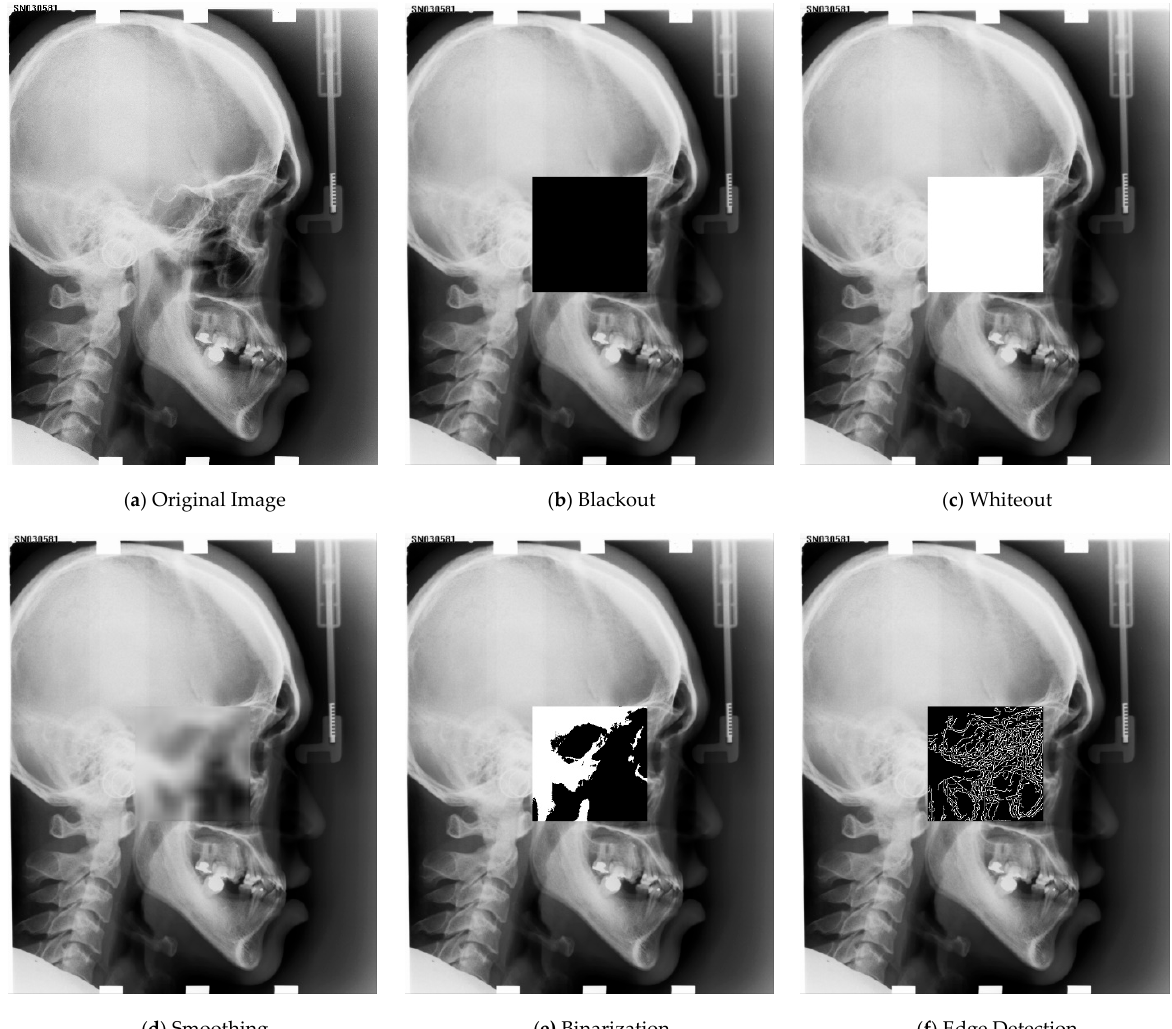
Figure 2. Visualization of perturbed images, ( a ) is the original image, ( b – f ) are the perturbed images, ( b ) is perturbed with blackout, ( c ) is perturbed with whiteout, ( d ) is perturbed with smoothing, ( e ) is perturbed with binarization, and ( f ) is perturbed with edge